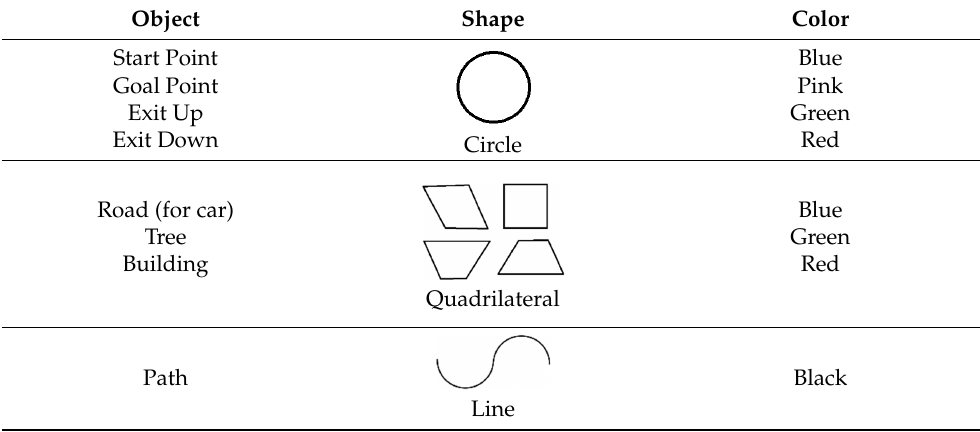
Table 2. Categorization of objects by shape and color.